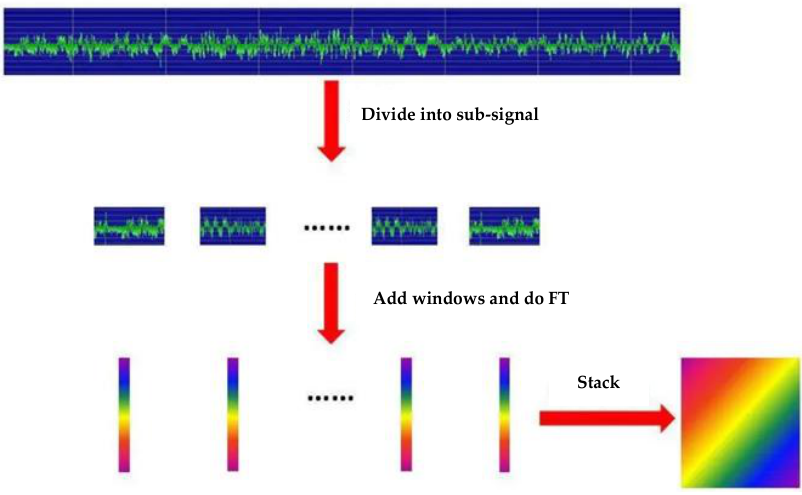
Figure 2. The operation process of STFT.